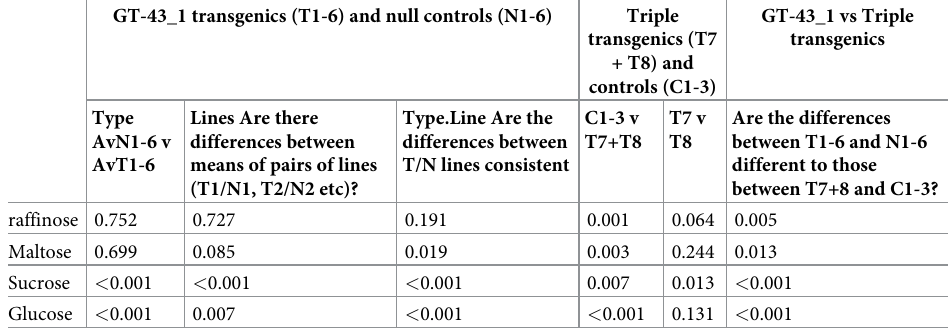
Table 5. ANOVA of sugars determined by NMR for GT43_1 and Triple RNAi lines compared to their Null and Controls